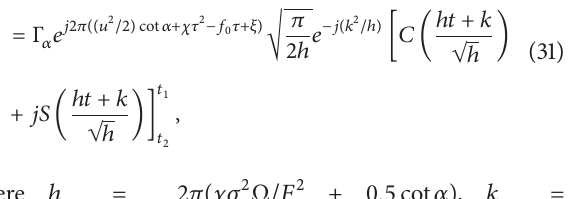
(𝜇 ) in SNR = − 15dB 𝑝 𝑝